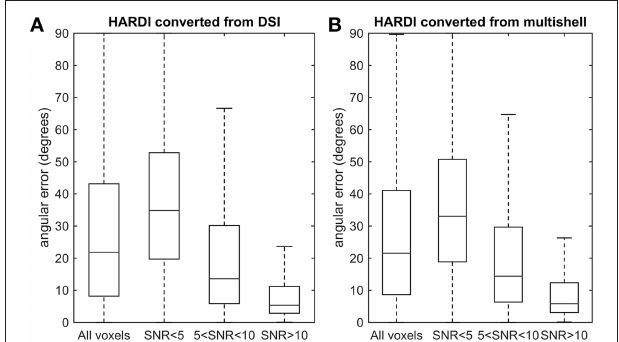
FIGURE 7 | Boxplots showing the angular error between (A) HARDI converted from DSI and the original HARDI and (B) HARDI converted from multishell and the original HARDI. Overall, the median of the angular error is around 20 ◦ . At voxels with SNR greater than 5, the angular error is substantially lower than the limit an orientation distribution function, suggesting that the fiber orientations calculated from the converted HARDI are sufficiently close to those of the original HARDI.